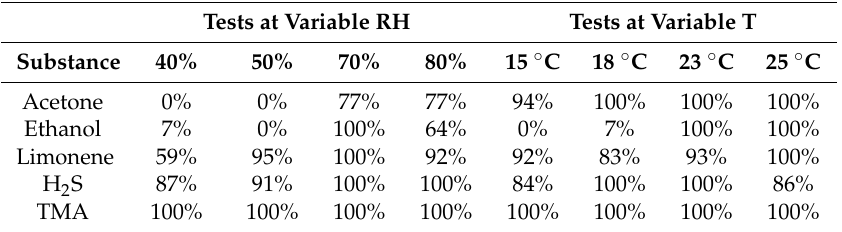
Table 5. Results of the tests for the evaluation of the electronic nose responses invariability to variable T and RH in terms of AI for each substance and for each condition